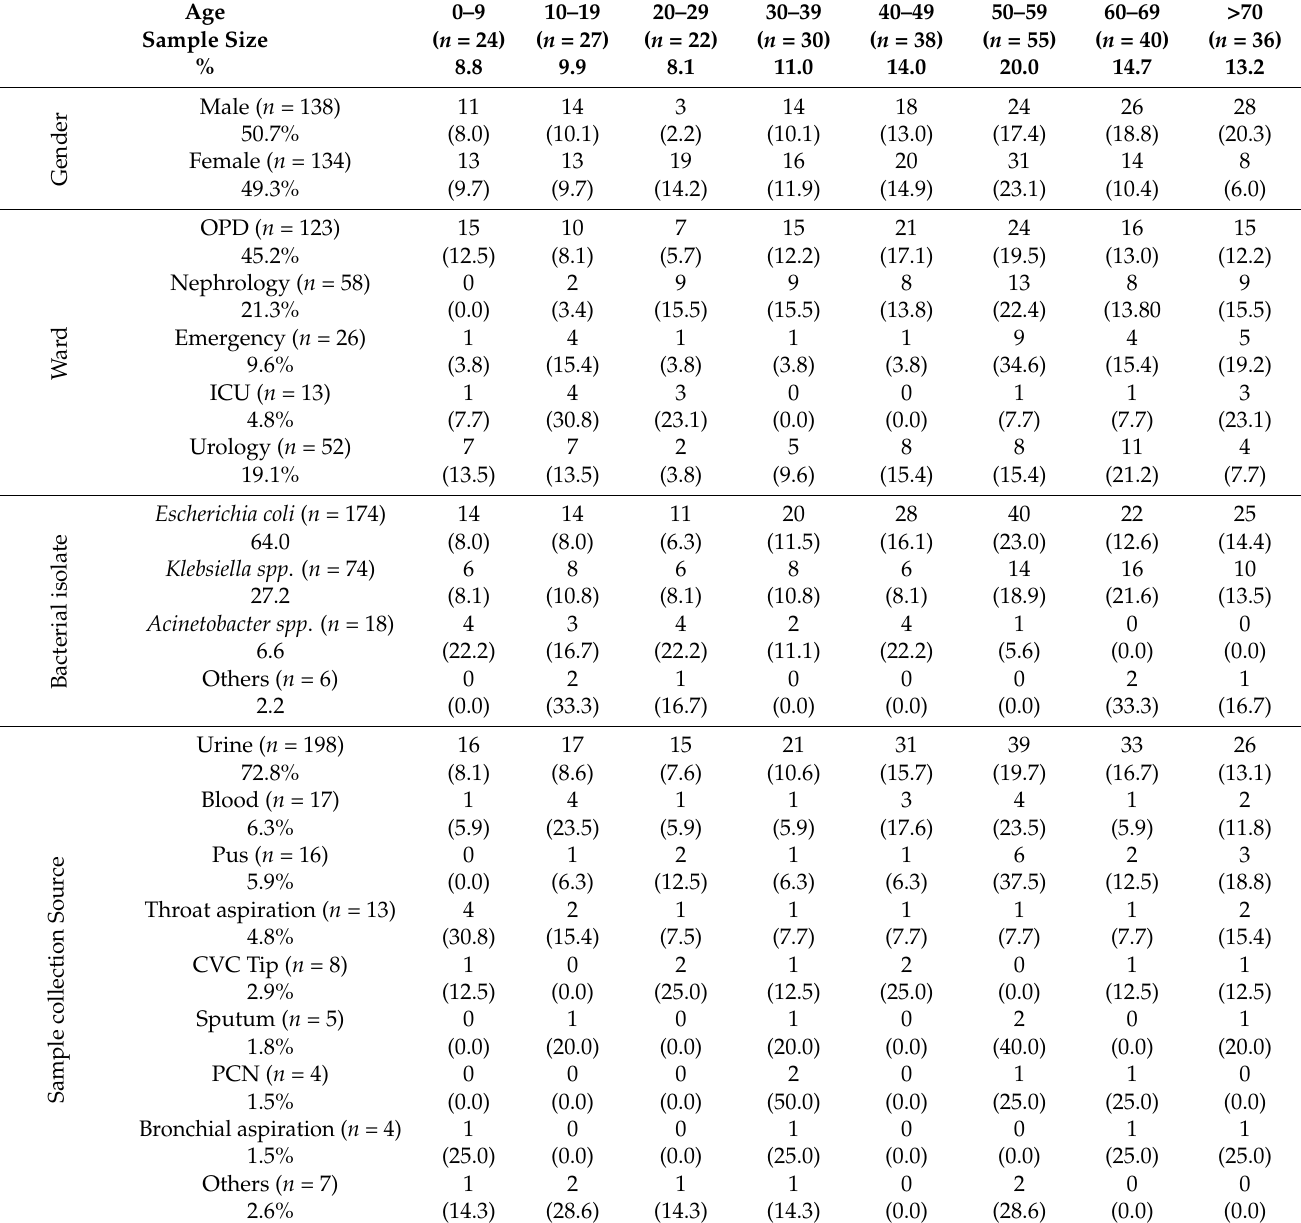
Table 1. Socio-demographic data of clinically isolated